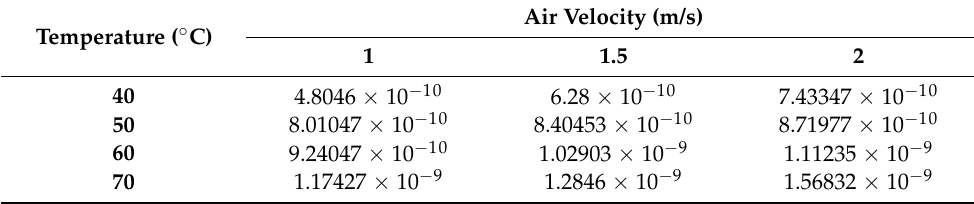
Table 1. Variation of D eff (m 2 /s) with drying air temperature and velocity. Temperature ( ◦ C)